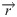
A) The between-subjects angle consistency is represented in a polar plot as the magnitude, i.e., the length, ranging from 0 to 1, of the vector r→ (|r→|), oriented towards the most frequent error direction (θ). The error vectors of three exemplificative participants are depicted. B) The between-subjects angle consistency did not significantly change over time but varied across fingertips and knuckles. To illustrate this, we plotted, for each normalized trial, the error direction separately for fingertips and knuckles, as a vector with constant magnitude 1 (note that, for visualization purposes, the proximo-distal dimension is ‘stretched’ compared to the medio-lateral one, therefore each vector is represented in an elliptical, instead of circular, polar space, as depicted in the box). The between-subjects angle consistency for fingertips and knuckles is represented in the polar plots aside, as the magnitude, i.e., length, ranging from 0 to 1, of the average error vector, oriented towards the most frequent error direction for each landmark type. The asterisk indicates the significant main effect of type C) The quadratic function describing the effect of finger knuckle (coded as 1 to 5) on the between-subjects angle consistency is plotted in gray. Black diamonds indicate medians.